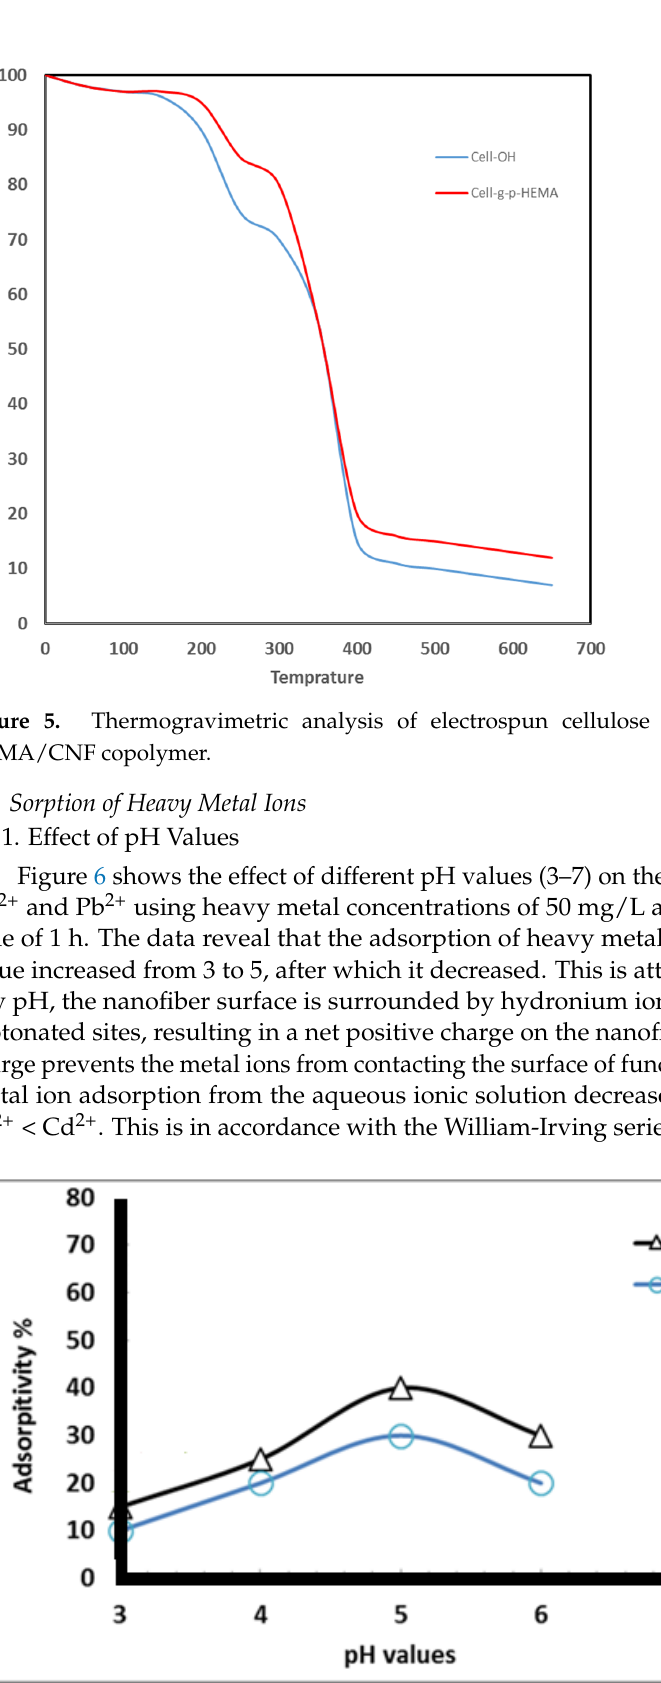
Figure 6. Adsorption percent of heavy metals at different pH values using 50 mg/L metal ion concentration and 1 h contact